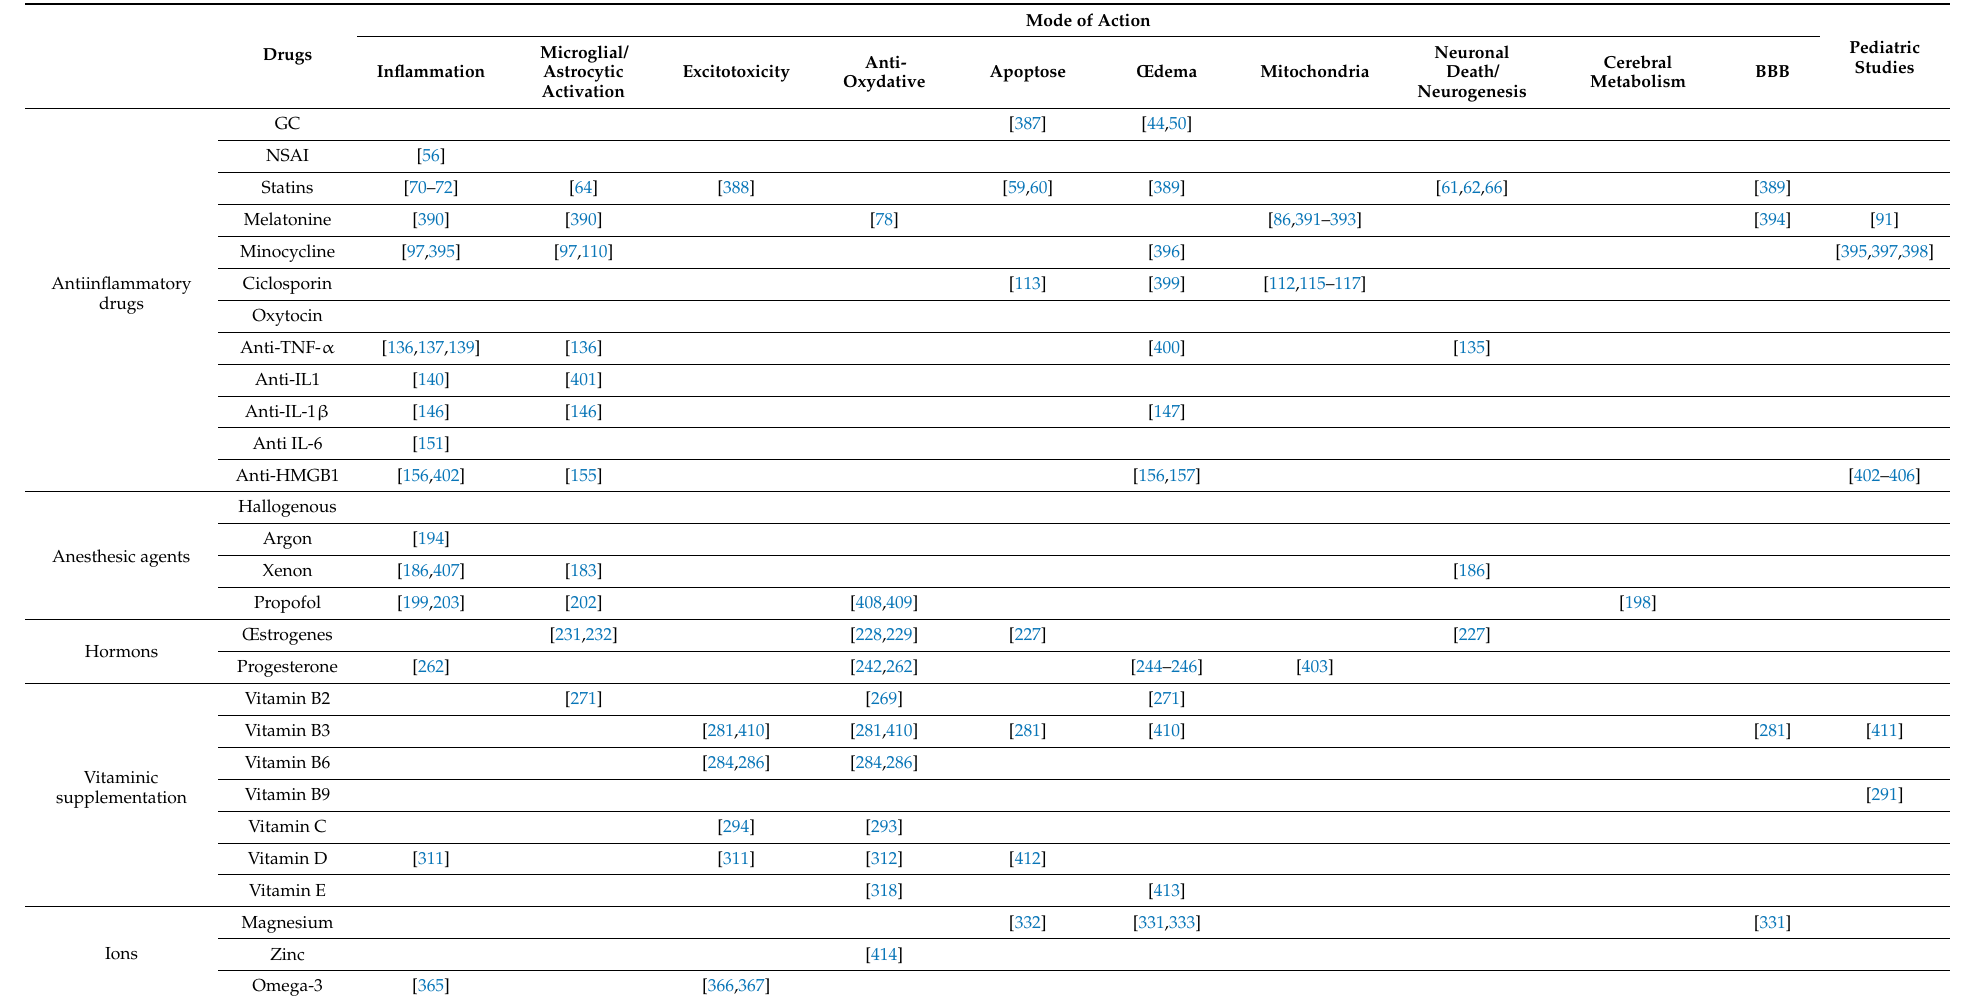
Table 1. Principal therapeutic drugs for traumatic brain injury and their mode of